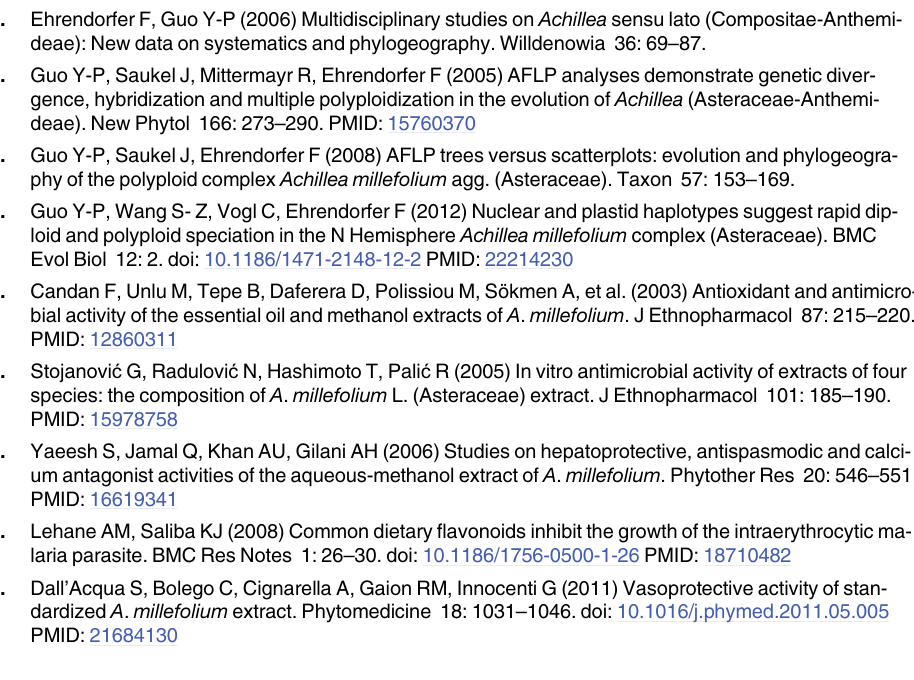
S1 Fig. Box-plots of the measurements of the stomata. SL = Stomata length; SW = Stomata width. S2 Fig. Principal component analysis performed from pairwise Nei ’ s genetic distances be- tween individuals. See Table 1 for population codes. S1 Table. Dimensions of stomata for individual populations of known ploidy (by count). See Table 1 for population codes. S2 Table. Dimensions of stomata for ploidy level. See Table 1 for population codes. S3 Table. Dimensions of stomata and estimated ploidy level for populations withouth counts. See Table 1 for population